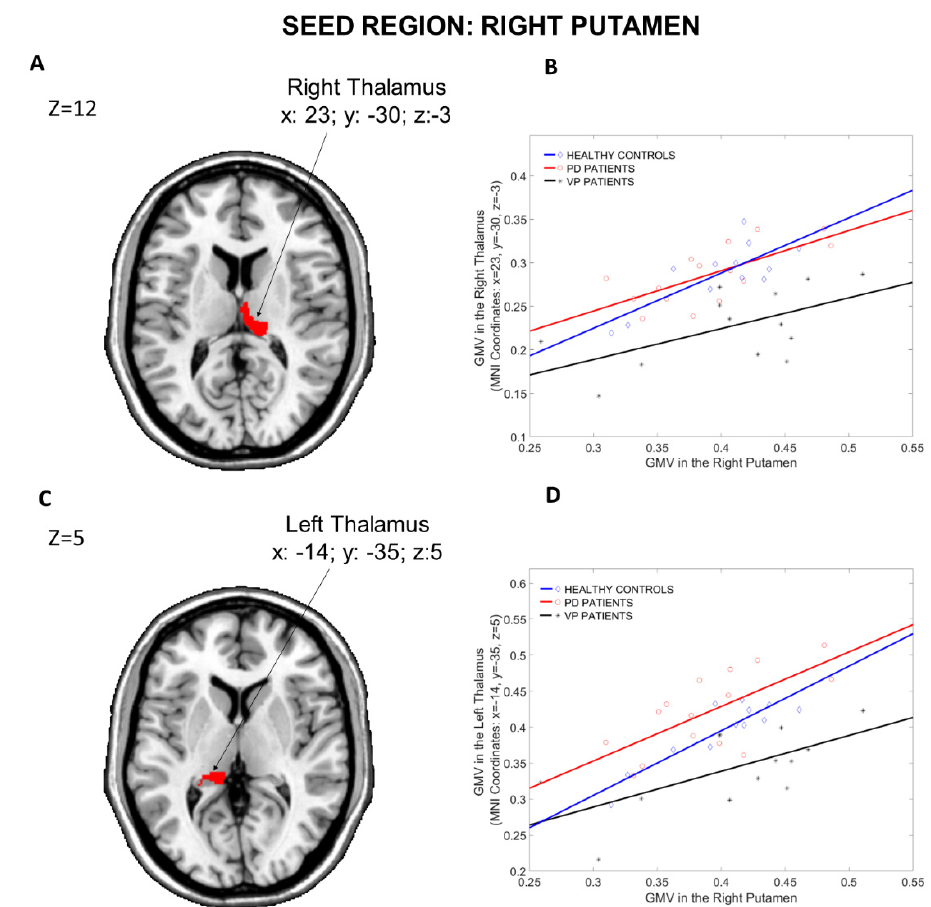
Figure 6. Group differences in the structural covariance of the Right Putamen. Brain maps are displayed using the neurological view. Panel ( A ): Voxels of the Right Thalamus that expressed differences in the structural association across the three groups. Panel ( B ): Correlations between the mean gray matter volume of the Right Putamen and the regional gray matter volume extracted from a 4 mm-radius sphere centered on the peak voxels of the significant cluster (x: 23, y = − 30, z: − 3). Panel ( C ): Voxels of the Left Thalamus that expressed differences in the structural association across the three groups. Panel ( D ): Correlations between the mean gray matter volume of the Right Putamen and the regional gray matter volume extracted from a 4 mm-radius sphere centered on the peak voxels of the significant cluster (x: − 14, y = − 35, z: 5). Blue diamonds represent HCs, red circles rep- resent PD patients and black crosses represent VP patients. GMV: gray matter volume; HCs: healthy controls; PD: Parkinson’s disease; VP: vascular parkinsonism. 3.2. Modulation Analysis of Structural Covariance The results of the modulation analysis between the structural covariance connectivity and the scores of cognitive tests in the VP group are reported in Table 6. Modulation ef- fects of COWAT, RAVLT-RD, MCST, BDI and HAMA scores were found in the structural connectivity between Right Caudate and Right Insula (Table 6A). A significant interaction between BDI scores and the Right Caudate–Left Thalamus connectivity as well as between MCST scores and Right Putamen–Left Thalamus connectivity was found (Table 6B,C). No other significant modulation effects were found ( p > 0.06).